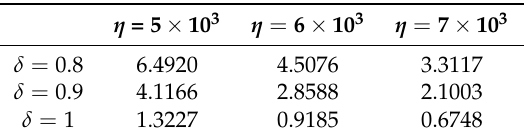
Table 1. The least upper bound of σ for Example